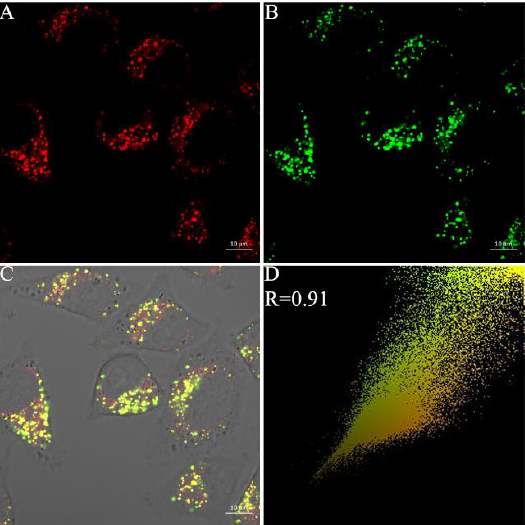
Figure 5. Co-localization of Py-SiRh-NTR and LysoTracker green in HepG2 cells. The cells were incubated under the hypoxiccondition of 1% O 2 with Py-SiRh-NTR (2 μM), and treated with LysoTracker green (2 μM). ( A ) The fluorescence from the Py-SiRh-NTR . ( B ) The fluorescence from the LysoTracker green. ( C ) Merged image of images ( A , B ). ( D ) Intensity correlation plot between Py-SiRh-NTR and LysoTracker green.